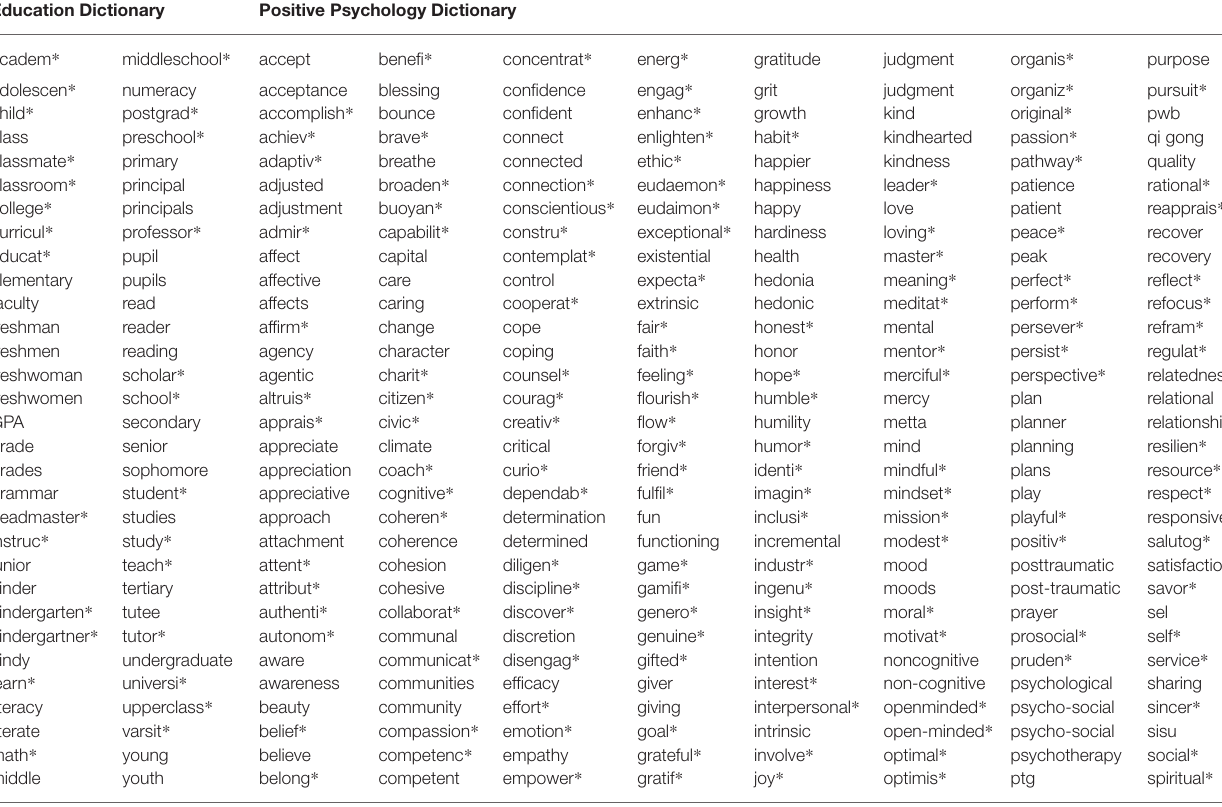
TABLE 3 | Words and word stems forming the positive education